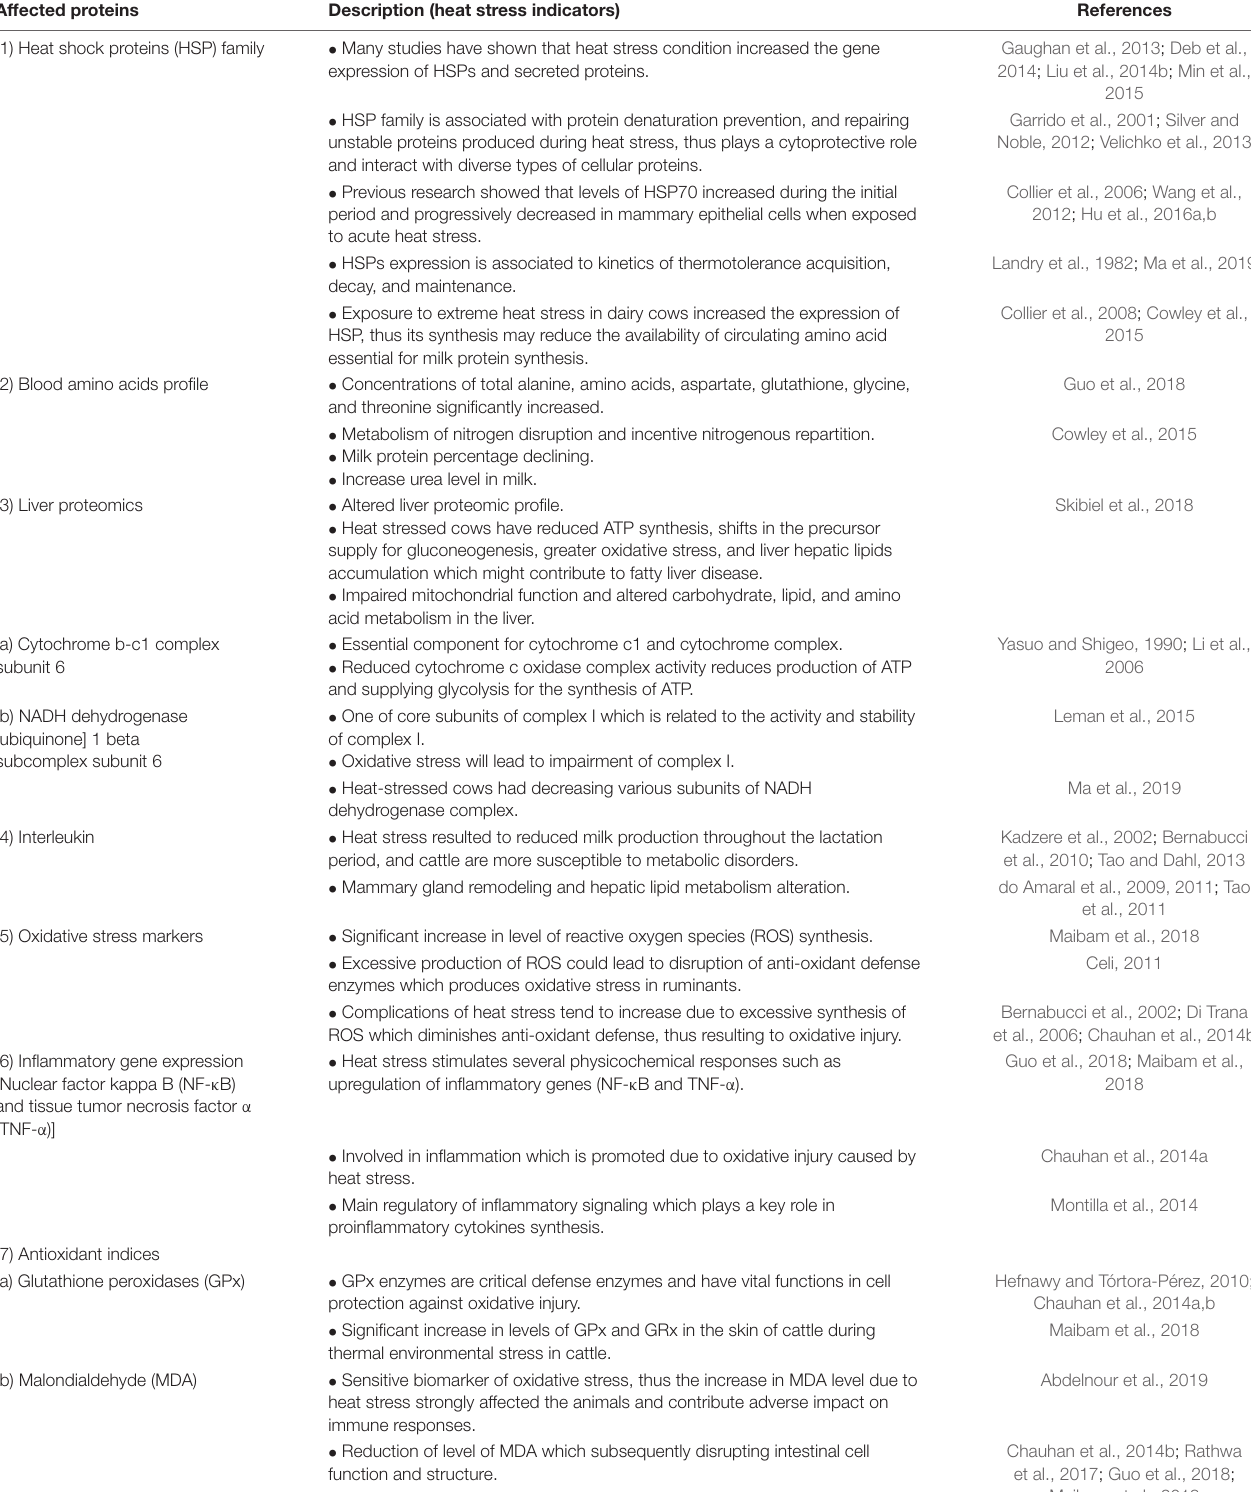
TABLE 2 | Impact of heat stress on proteomic profile of dairy cows. Affected proteins Description (heat stress